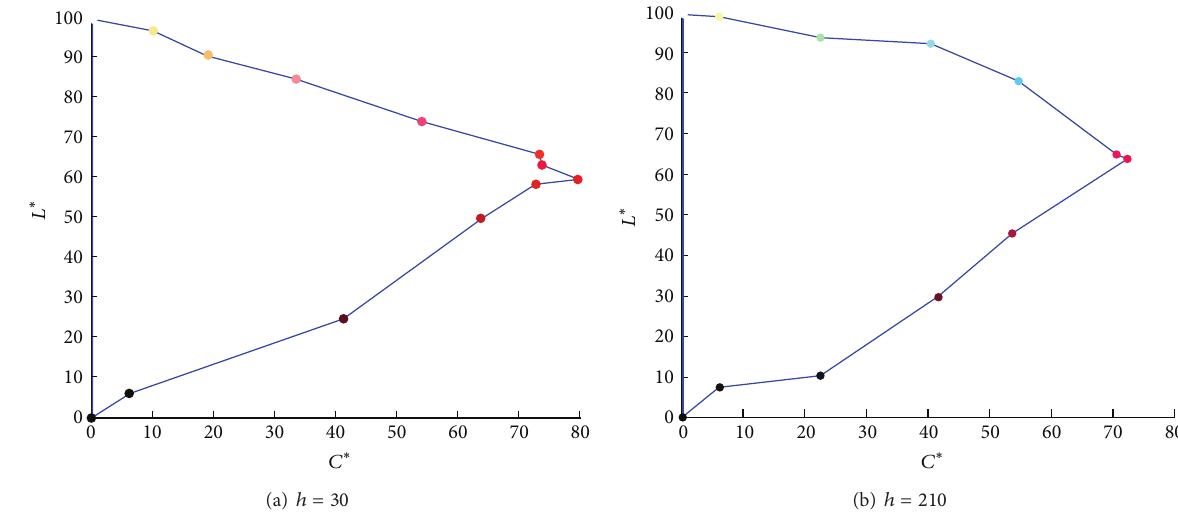
Figure 8: The 2D gamut with different hue